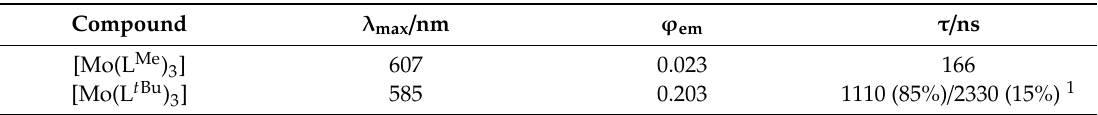
Table 1. Emission band maxima ( λ max ), luminescence quantum yields ( ϕ em ), and 3 MLCT lifetimes ( τ ) in de-aerated toluene at 20 ◦ C [27].